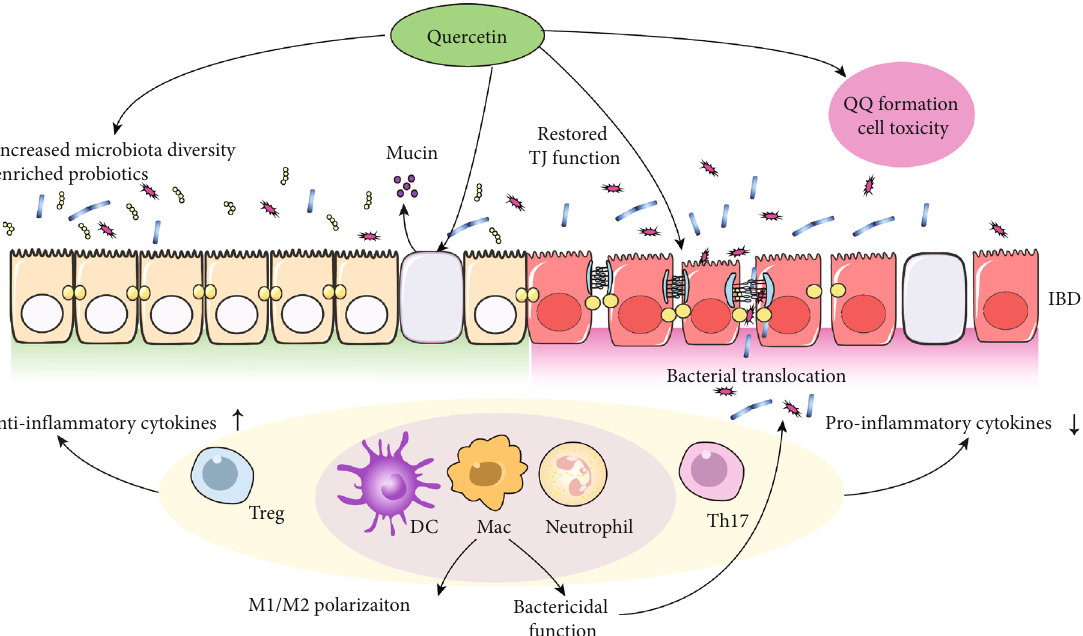
Figure 1: The action modes of quercetin in IBD treatment. Administration of quercetin provides bene fi cial anti-IBD e ff ect through reshaping gut microbiota, stimulating the mucin production of goblet cells, strengthening the tight junction (TJ) of intestinal barrier, and restoring immune balance in colonic microenvironment. Nonetheless, administration of quercetin may bring about unwanted side e ff ects through the generation of o-quinone/quinone methide (QQ) and subsequent cell toxicity.